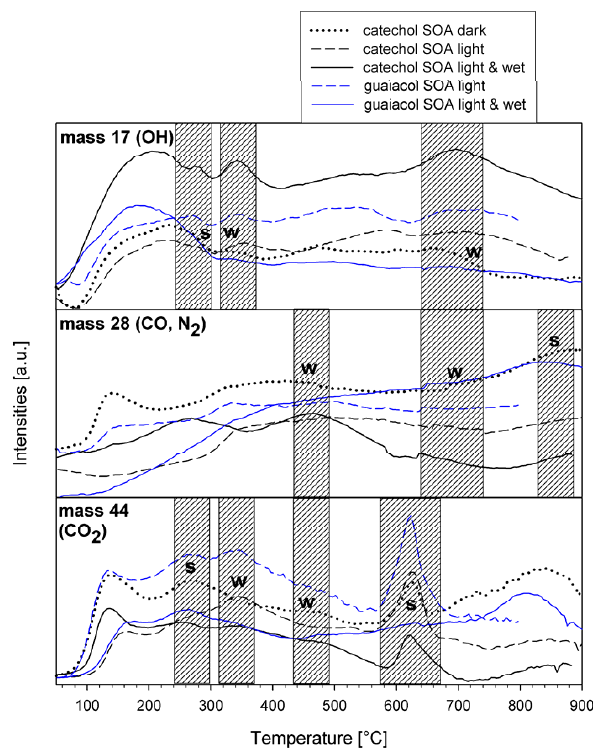
Fig. 10. TPP signals of the three important masses 17 (OH), 28 (CO or N2) and 44 (CO2) observed as a function of temperature for the five different SOA particles. The hatched temperature ranges mark observed decomposition of the following functional groups in soot: carboxylic acid (270 and 320), carboxylic acid anhydride (460), lactone and ester (620), phenol (680, m/z =17), ether (680; m/z =28), and carbonyl and quinone (860). The strengths of these features are indicated as s (strong) and w (weak) for catechol SOA dark, and are compared with each other SOA in Table 3.